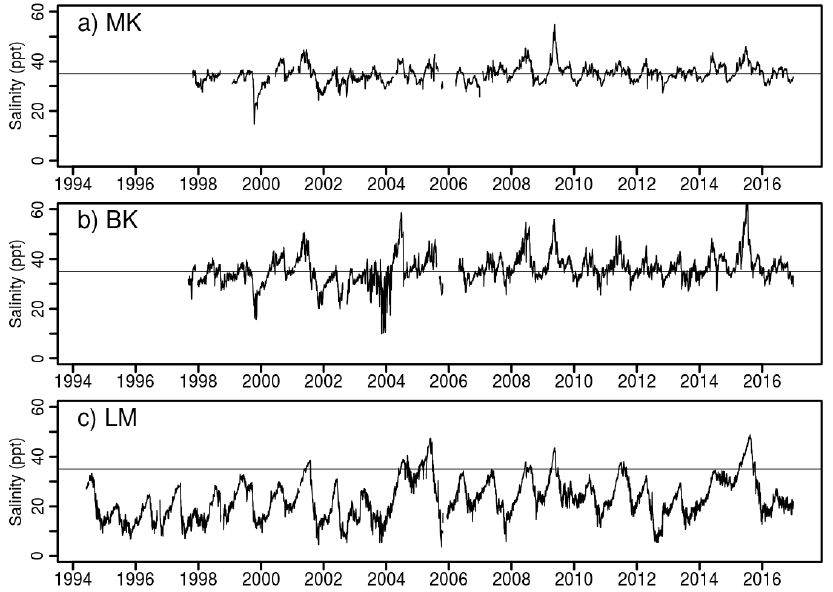
Figure 4. Daily mean salinity at 3 stations in Florida Bay. The horizontal line at 35 ppt represents nominal seawater salinity. ( a ) MK; ( b ) BK; ( c )